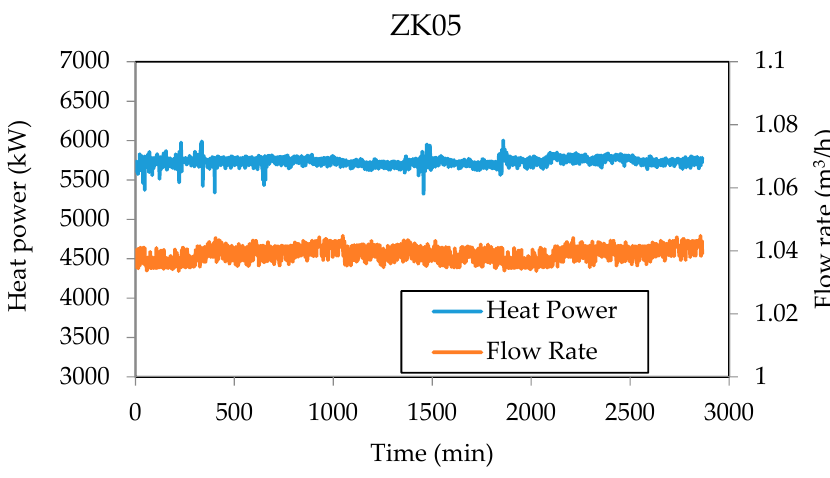
Figure 16. Heat power and fluid flow rate during the test. Table 3. The standard thermal response test (TRT) results.